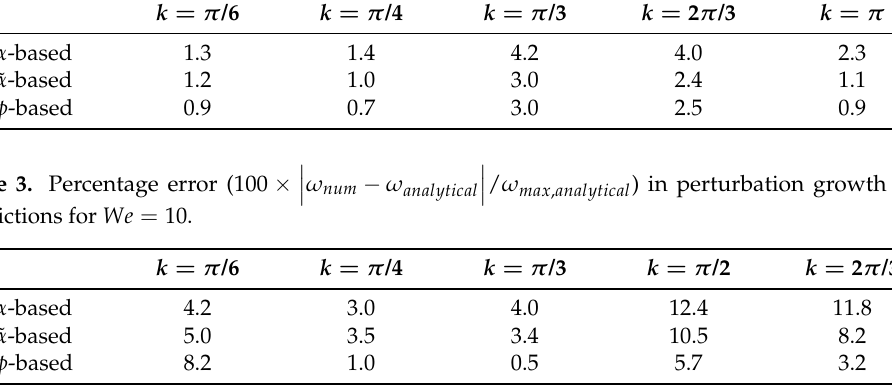
(cid:12) (cid:12) (cid:12) (cid:12) − ω analytical (cid:12) ω num (cid:12) / ω max , analytical ) in perturbation growth rate